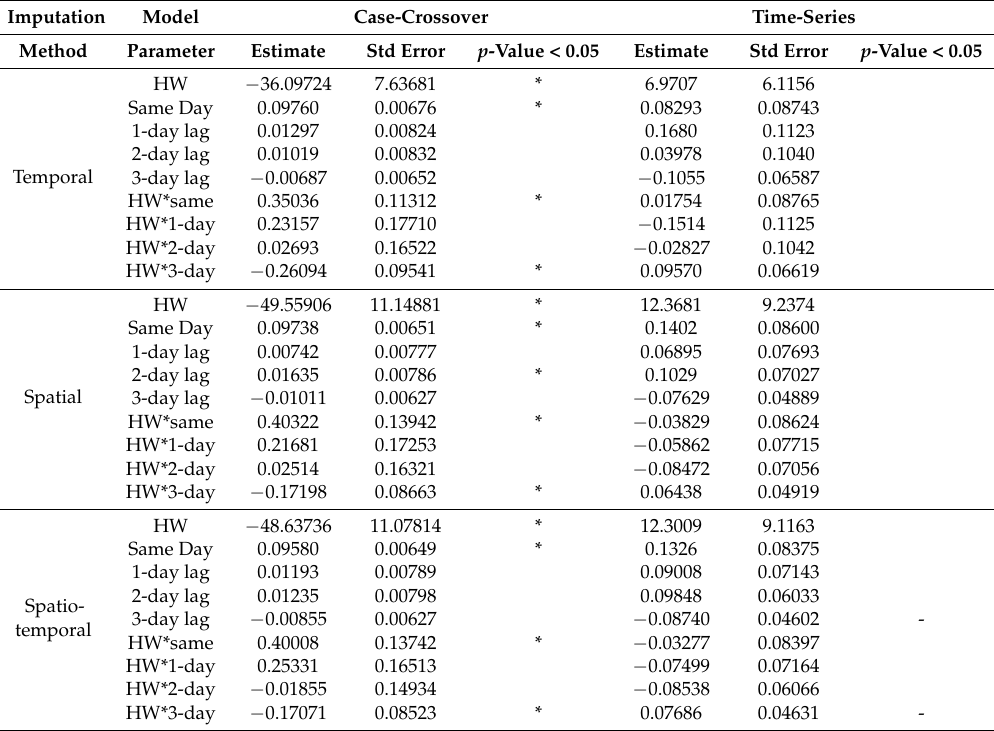
Table 4. Case-crossover and time-series results for the JAX region using the temporal, spatial